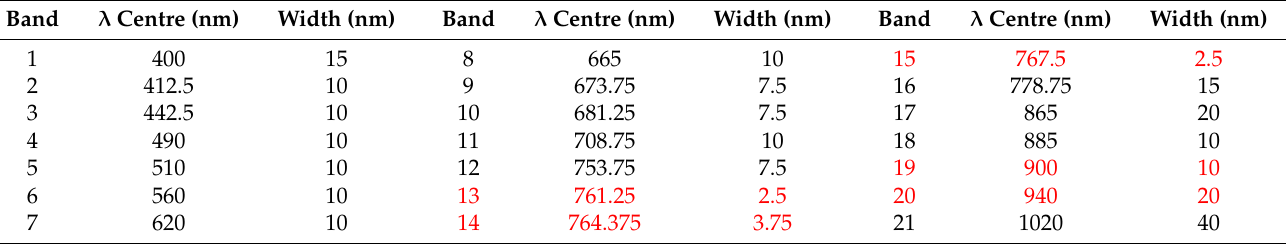
Table 1. Band characteristics of the Sentinel-3 Ocean and Land Colour Instrument